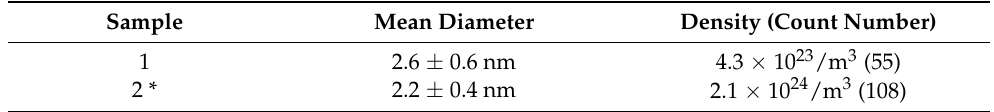
Figure 5. Results of APT observation in the irradiation sample 1. Left: distribution of individual clusters, middle: distribution map of Si atoms, right: distribution map of Ni atoms. Table 3. Mean diameters and volume number densities of solute atom clusters. * The data of sample 2 are from Ref. [14].